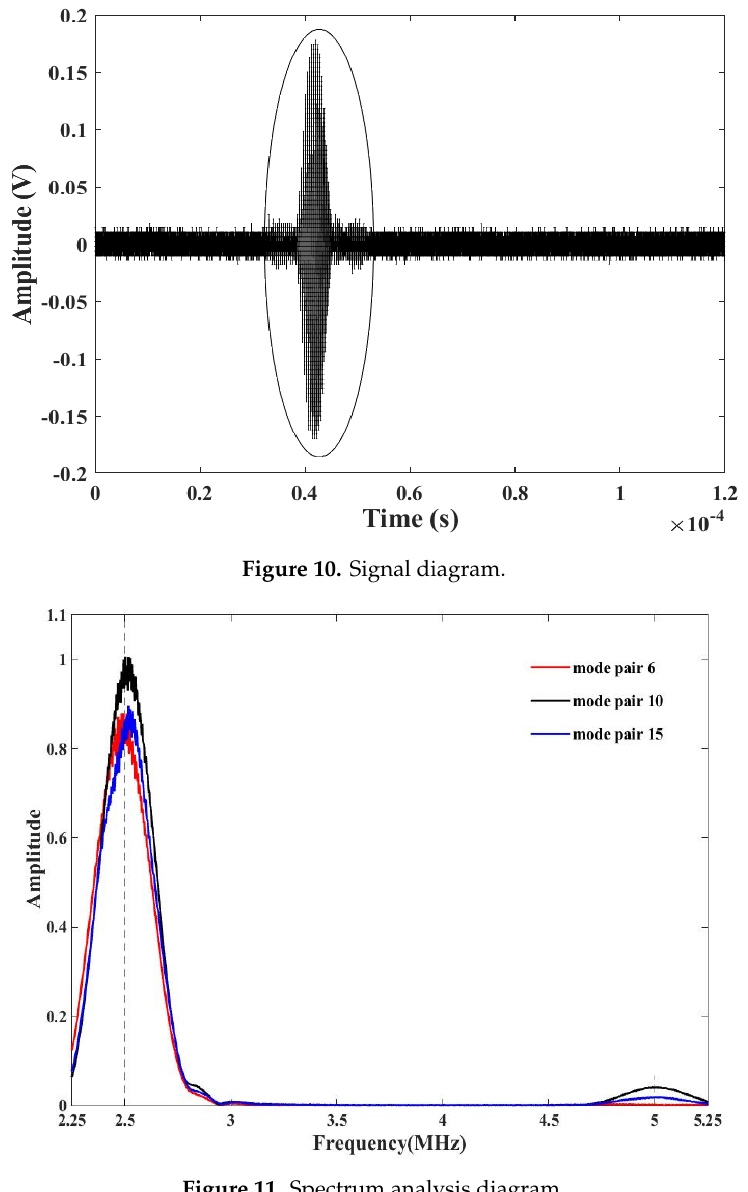
Figure 11. Spectrum analysis diagram.